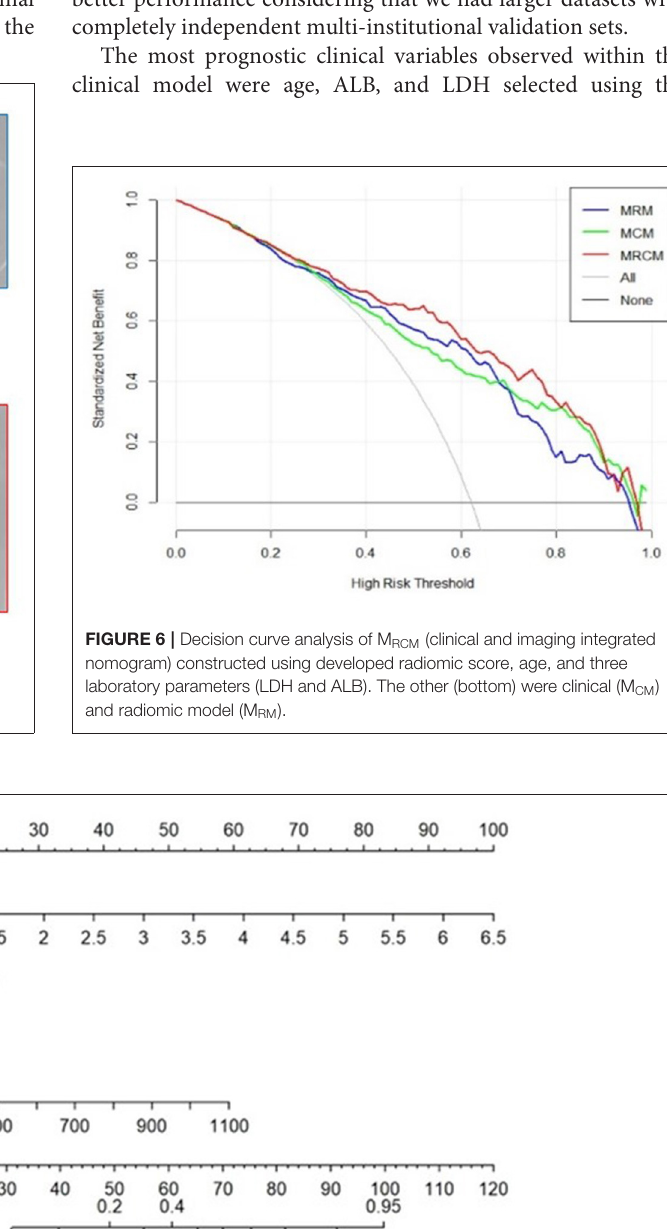
Frontiers in Radiology |